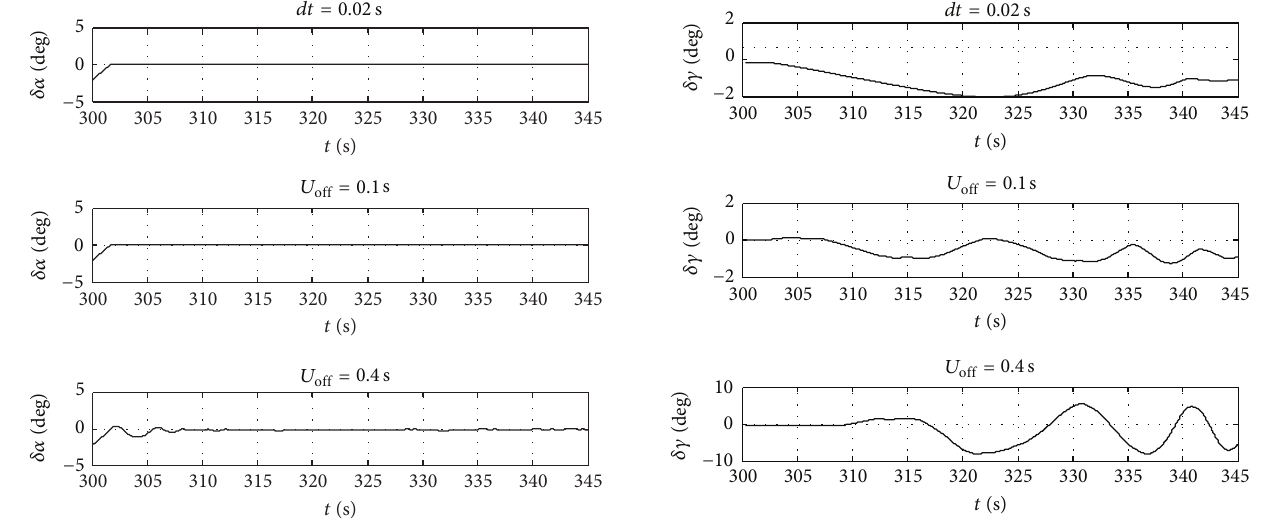
with Figure 15. This characteristic is decided by the